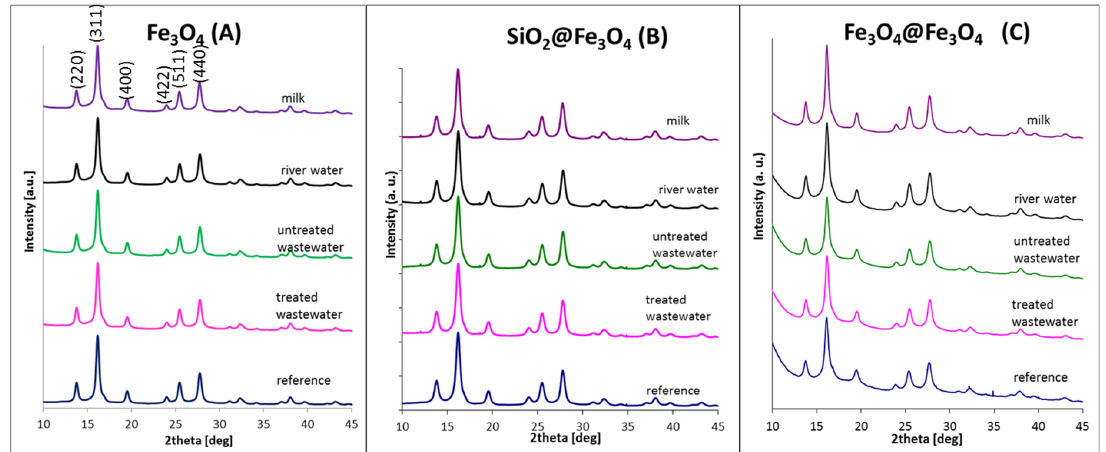
Figure 2. X-ray diffraction patterns of tested nanoparticles in various environmental solutions: ( A ) Fe 3 O 4 ; ( B ) SiO2@Fe 3 O 4; ( C ) Fe 3 O 4 @Fe 3 O 4 .